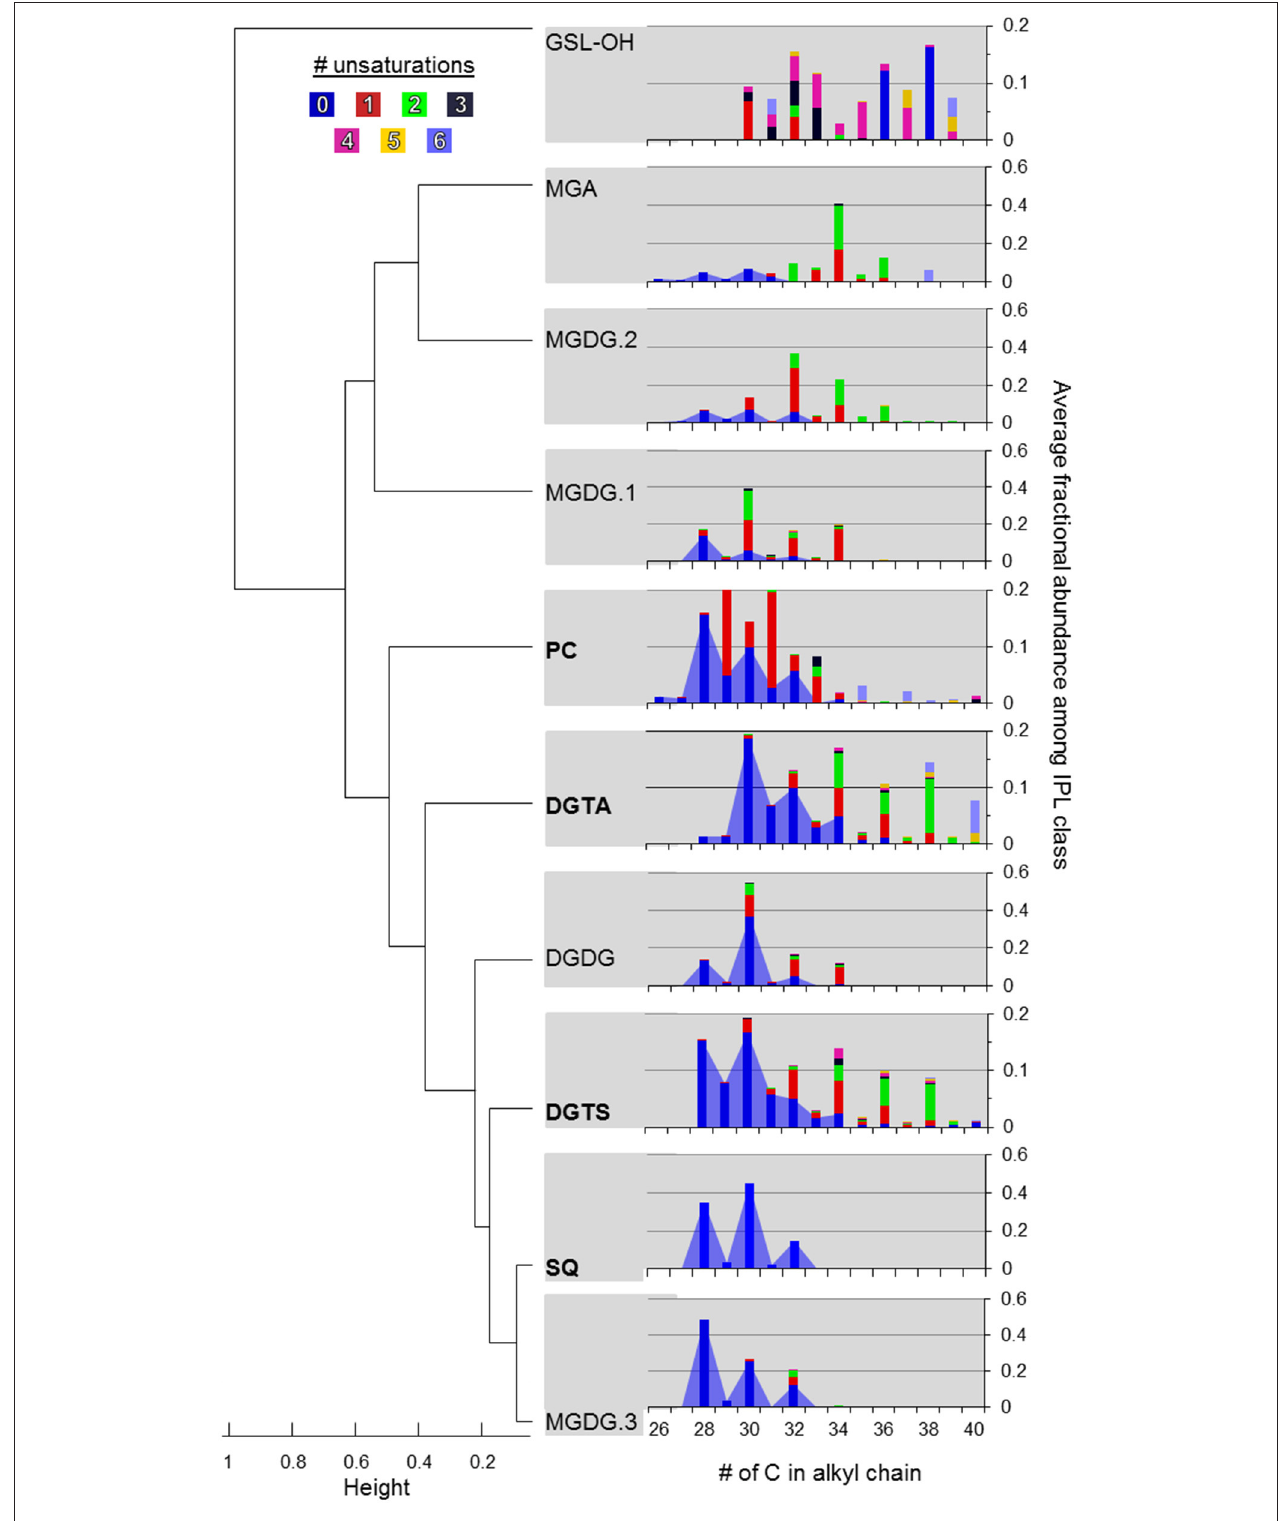
FIGURE 5 | Hierarchical clustering of IPL classes based on alkyl chain distributions in their diacylglycerol moiety. Agglomeration was determined via the unweighted average distance algorithm (UPGMA) and dissimilarity was measured as one minus the Pearson correlation. IPLs shown in bold are thought to be modulated by plankton in response to P-limitation (cf. Van Mooy et al., 2009). The color code refers to the number of unsaturations in the alkyl chains. The blue area shows the relative abundance of saturated alkyl chains summing to ≤ 34 carbons.